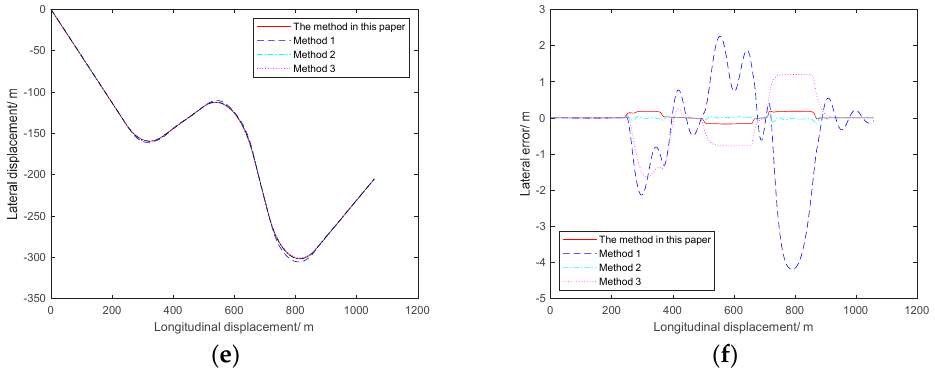
Figure 8. Alt 3 simulation results at different speeds: ( a ) 36 km/h path ‐ tracking effect. ( b ) 36 km/h lateral tracking error. ( c ) 72 km/h path ‐ tracking effect. ( d ) 72 km/h lateral tracking error. ( e ) 108 km/h path ‐ tracking effect. ( f ) 108 km/h lateral tracking error.